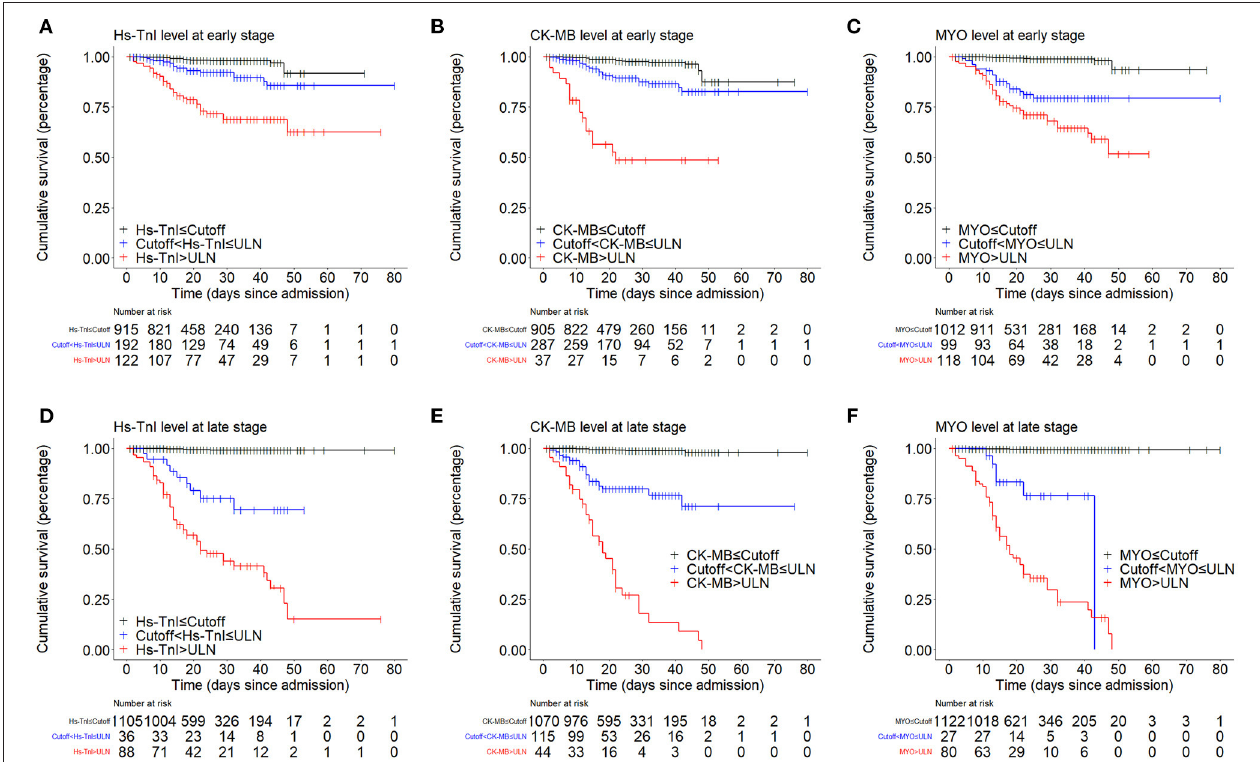
FIGURE 3 | Kaplan-Meier curves showing the cumulative survival rates of patient groups divided by cut-off and ULN. (A–C) Kaplan-Meier curve analysis based on the early-stage levels of myocardial biomarkers. (D–F) Kaplan-Meier curve analysis based on the late-stage levels of myocardial biomarkers. ULN, upper limit of